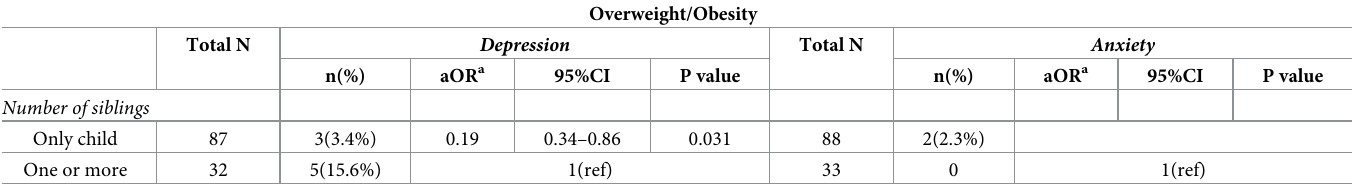
Table 3. Adjusted odd ratios of anxiety and depression at follow-up for the number of siblings in overweight/obesity group.